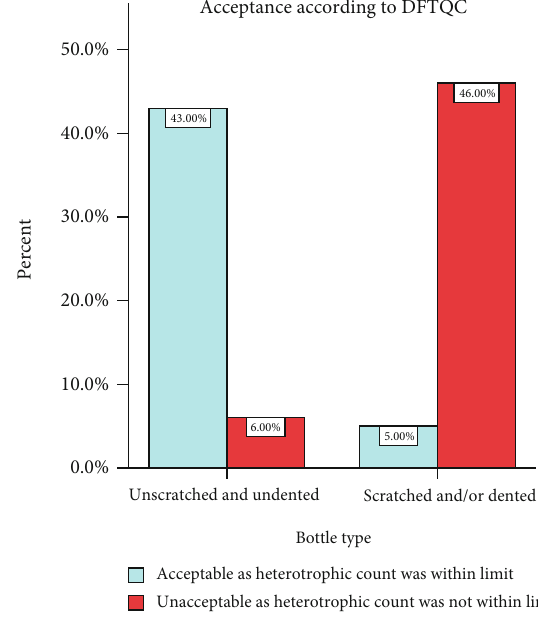
Figure 4: Distribution of HPC with respect to the physical condition of the bottled water